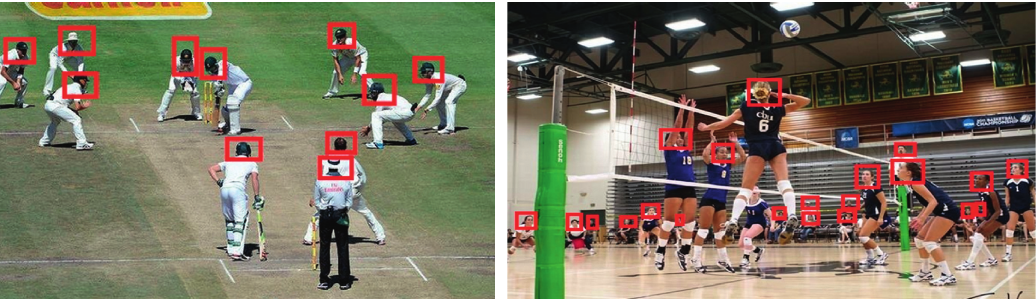
Figure 7: Trace result graph.